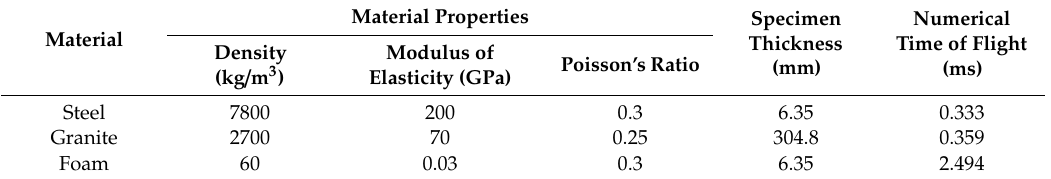
Table 1. Mechanical properties, specimen thickness, and the predicted ToFs of the steel, granite, and foam specimens in the numerical